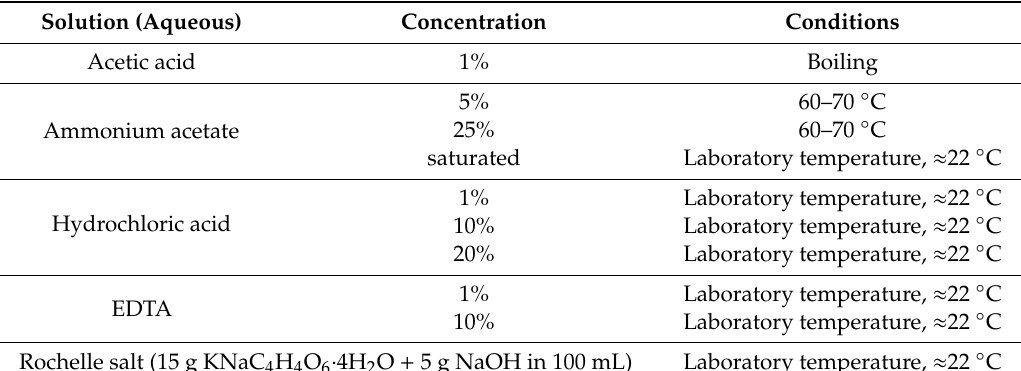
Table 2. Tested cleaning solutions for removal of model corrosion